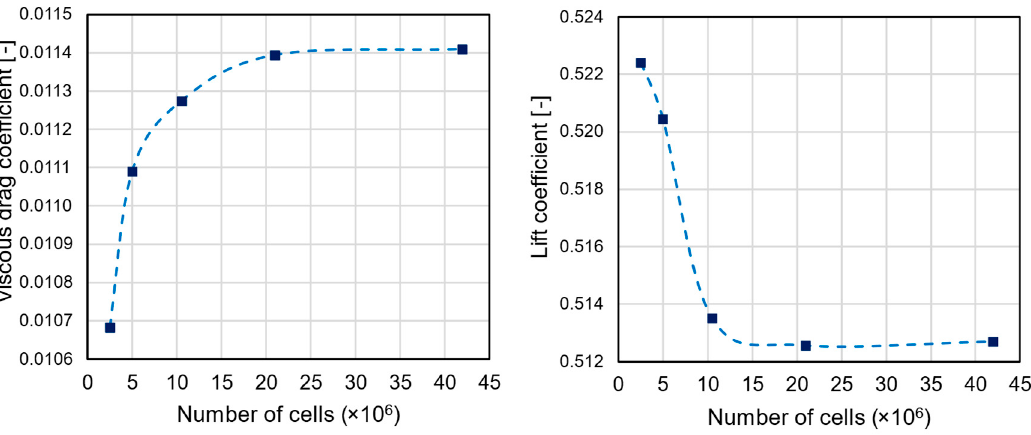
Figure 5. Grid independency study for the HCUAV RX-1 at loiter conditions.